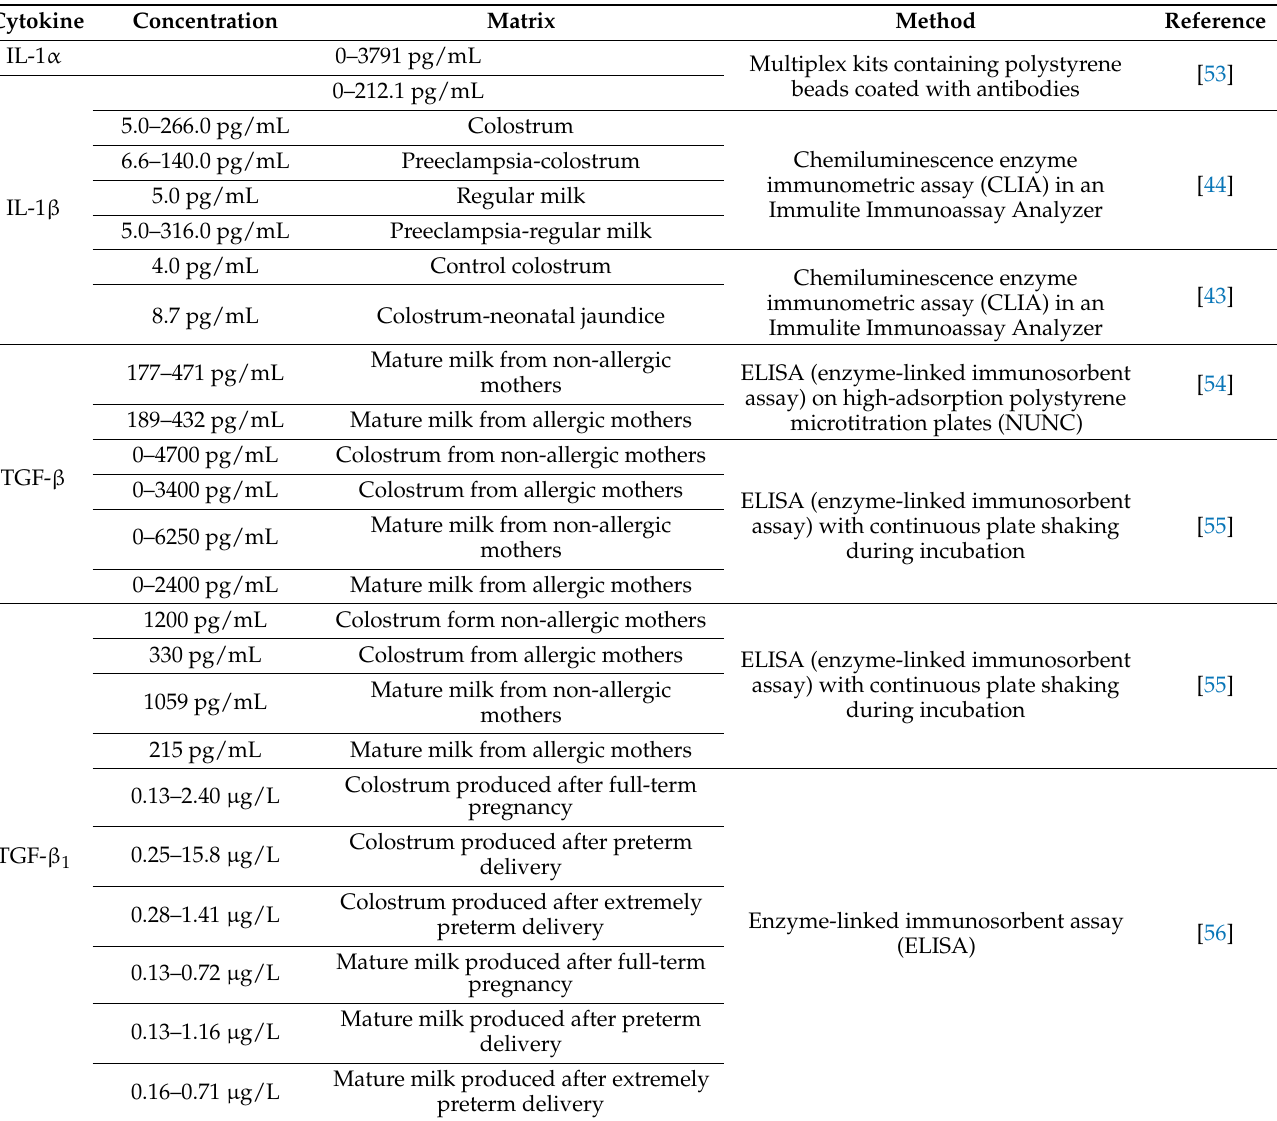
Table 1. Methods of cytokine detection in human breast